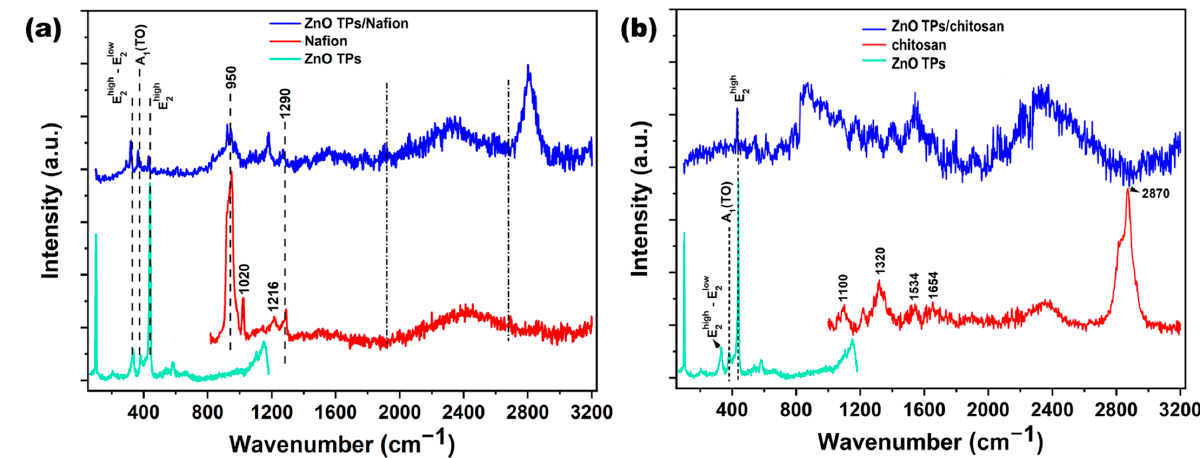
Figure 3. Raman spectra of ZnO TPs/Nafion (blue curve in figure ( a )), and ZnO TPs/chitosan (blue curve in figure ( b )) samples. Here, the light blue spectra in ( a,b ) are attributed to the ZnO TPs, the red curve in figure ( a ) is the Raman spectrum of Nafion, while the red curve in figure ( b) is attributed to the chitosan polymer.